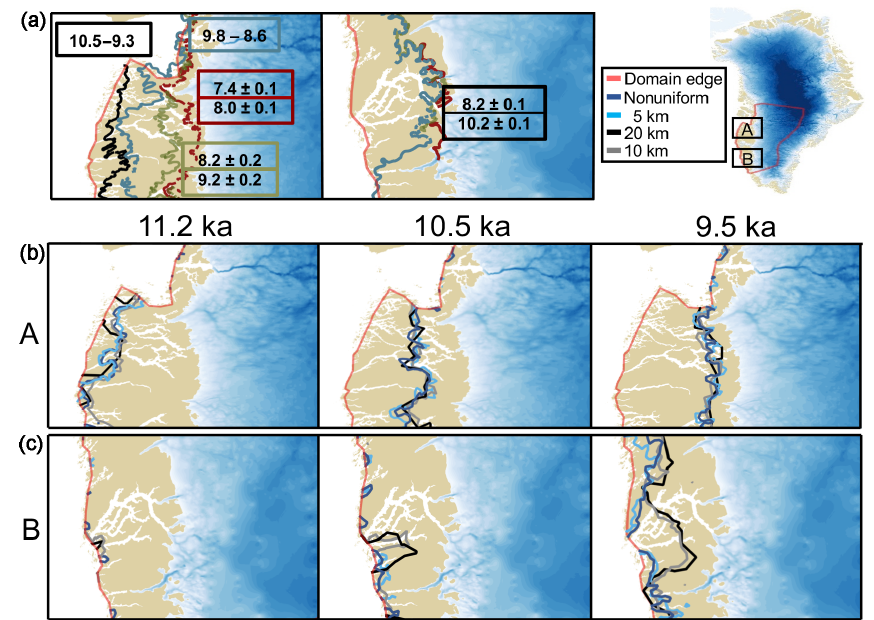
Figure 6. (a) Mapped moraines and the existing chronology of ice retreat over the northern and southern portion of our domain. The mapped moraines and corresponding ages of retreat were taken from Lesnek and Briner (2018). (b, c) Simulated ice sheet margin for the different model resolutions shown over locations in the northern (b) and southern (c) domain. The present-day ice thickness is shown, derived from Morlighem et al. (2017) and Howat et al. (2014).